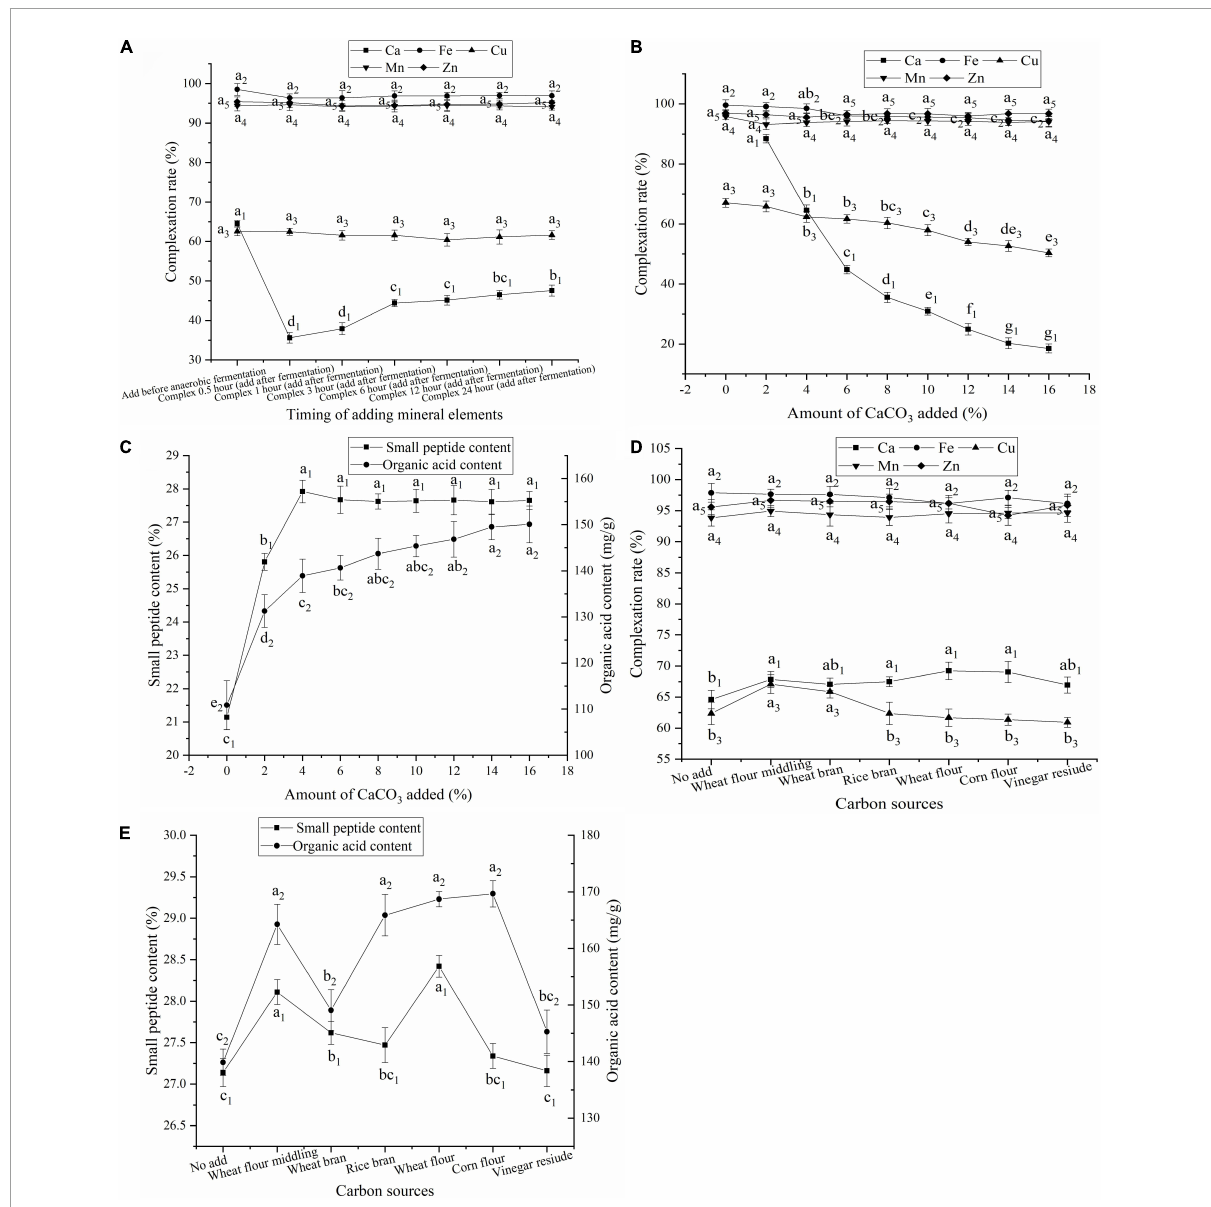
FIGURE1 (A) Effect of timing of adding mineral elements on the complexation rate; (B) Effect of amount of CaCO 3 added on the complexation rate; (C) Effect of amount of CaCO 3 added on contents of small peptides and organic acids; (D) Effect of carbon sources on the complexation rate; (E) Effect of carbon sources on contents of small peptides and organic acids; Values expressed as mean ± standard deviation ( n =